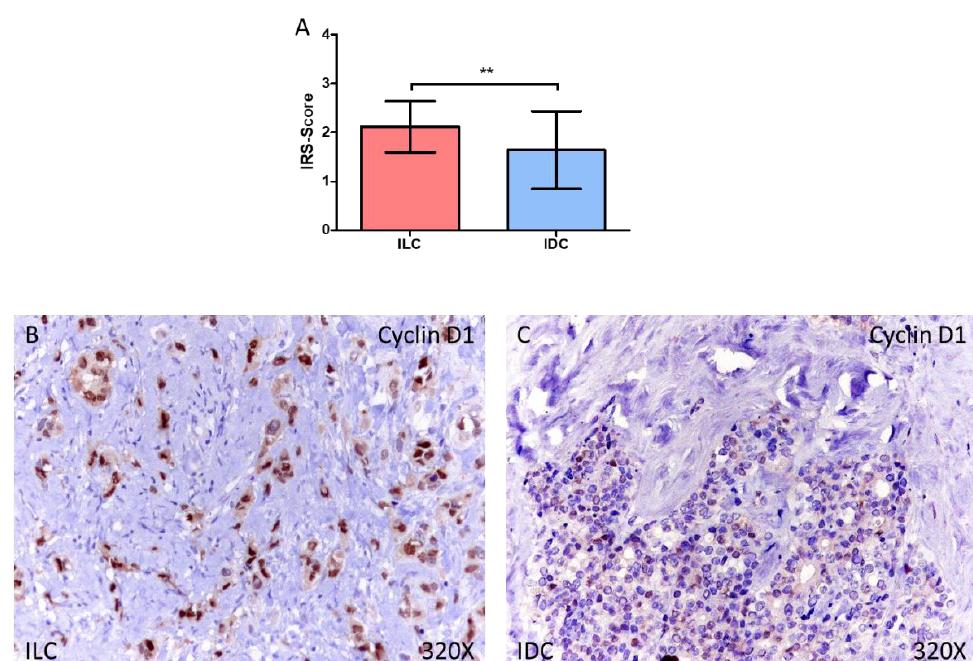
Figure 3. ( A ). IRS-Score for Rb1 in patients diagnosed with invasive lobular carcinoma (ILC) and infiltrative ductal carcinoma (IDC). ( B , C ). Histological images of Rb1 expression using immunohistochemical techniques in the breast tissue of patients diagnosed with ILC ( B ) and IDC ( C ). ** p < 0.005.